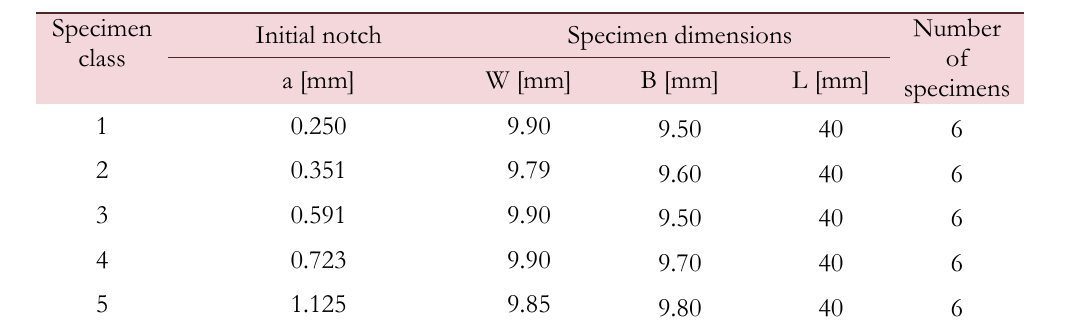
Table 2: Geometric characteristics of specimens and sizes of initial notch.